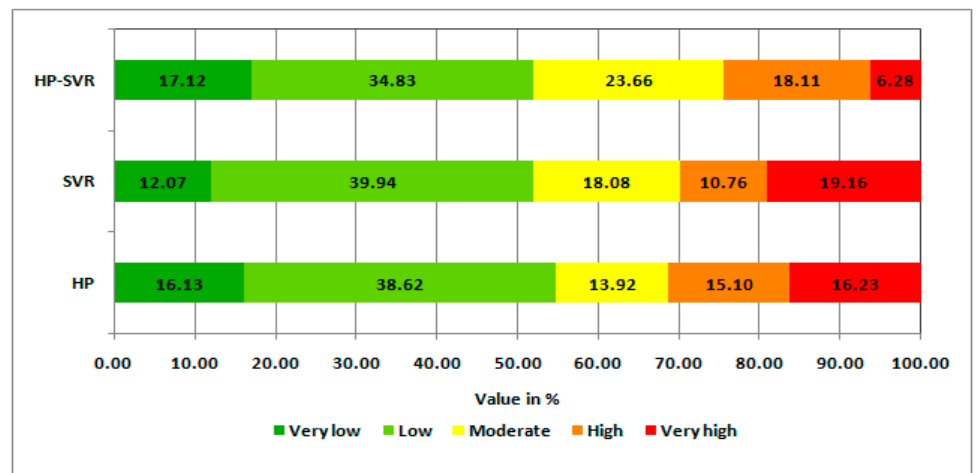
Figure 7. Distribution flood susceptibility zone of three models